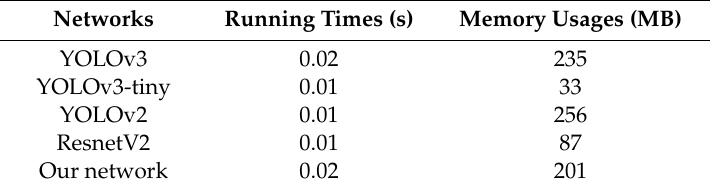
Table 4. The running times and the memory usages of the five networks.